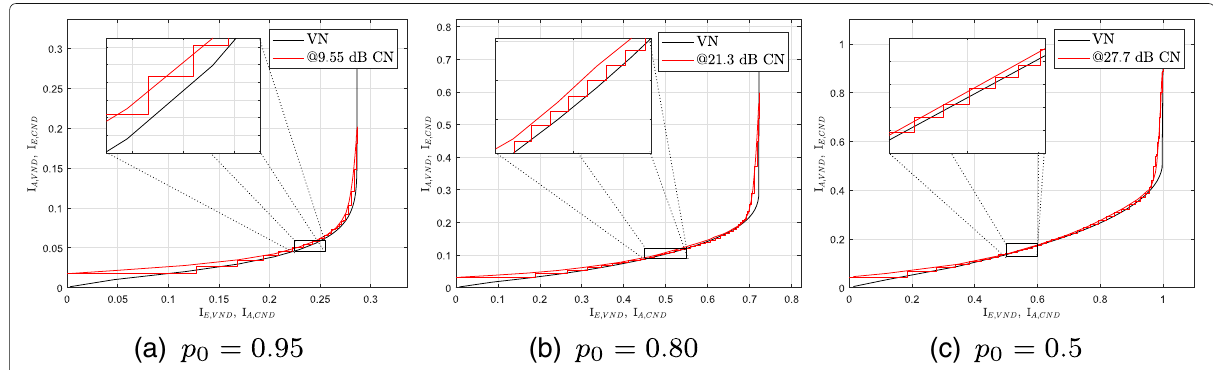
Fig. 10 EXIT chart and real trajectories of the designed codes for fast Rayleigh channel and sources with c p 0 = 0.5, b p 0 = 0.8, and a p 0 = 0.95